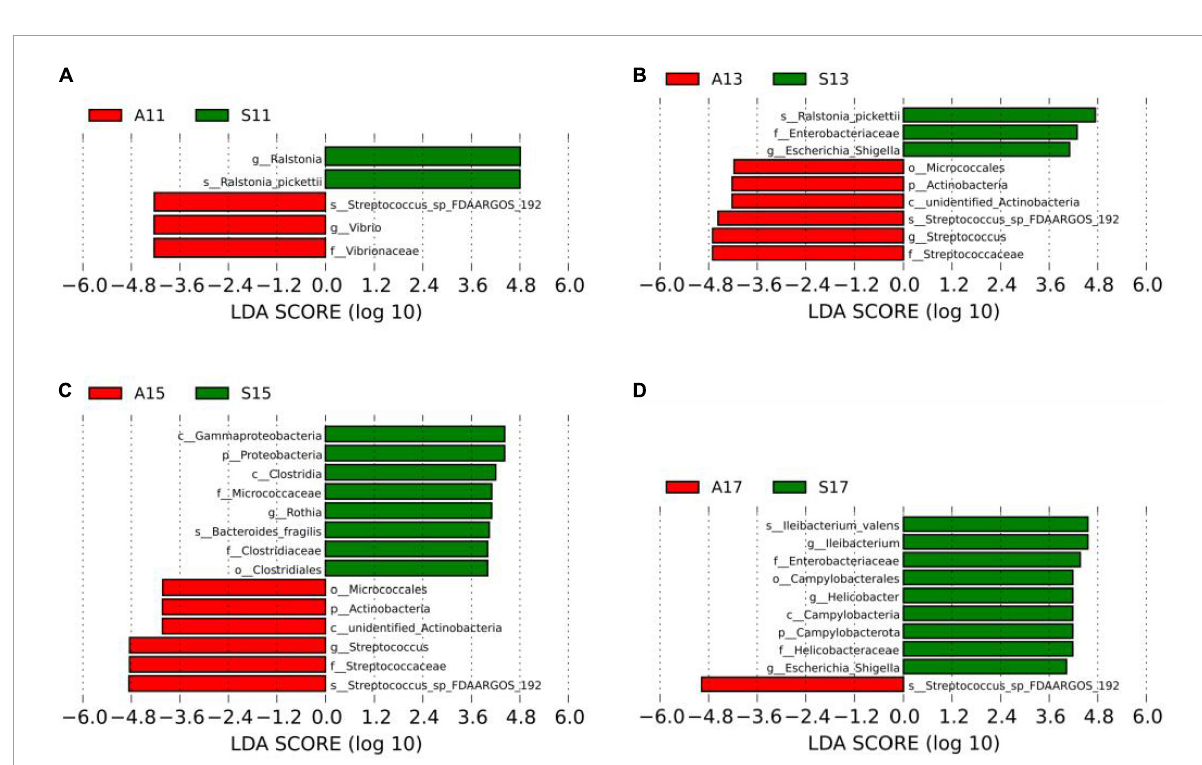
FIGURE3 LEfSe comparison between the SGA and AGA groups. (A) LDA score histogram of differential microbiota of the two groups on day 1. (B) LDA score histogram of differential microbiota of the two groups on day 3. (C) LDA score histogram of differential microbiota of the two groups on day 5. (D) LDA score histogram of differential microbiota of the two groups on day 7. p_ represents phylum level, c _ represents class level, o_ represents order level, f_ represents family level, g_ represents genus level, and s_ represents species level. The length of the column represents the LDA score, and the greater the score, the greater the influence of the dominant microbiota. LDA, linear discriminant analysis; LEfSe, linear discriminant analysis effect size. S11, gut microbiota of the SGA group on day 1; A11, gut microbiota of the AGA group on day 1; S13,